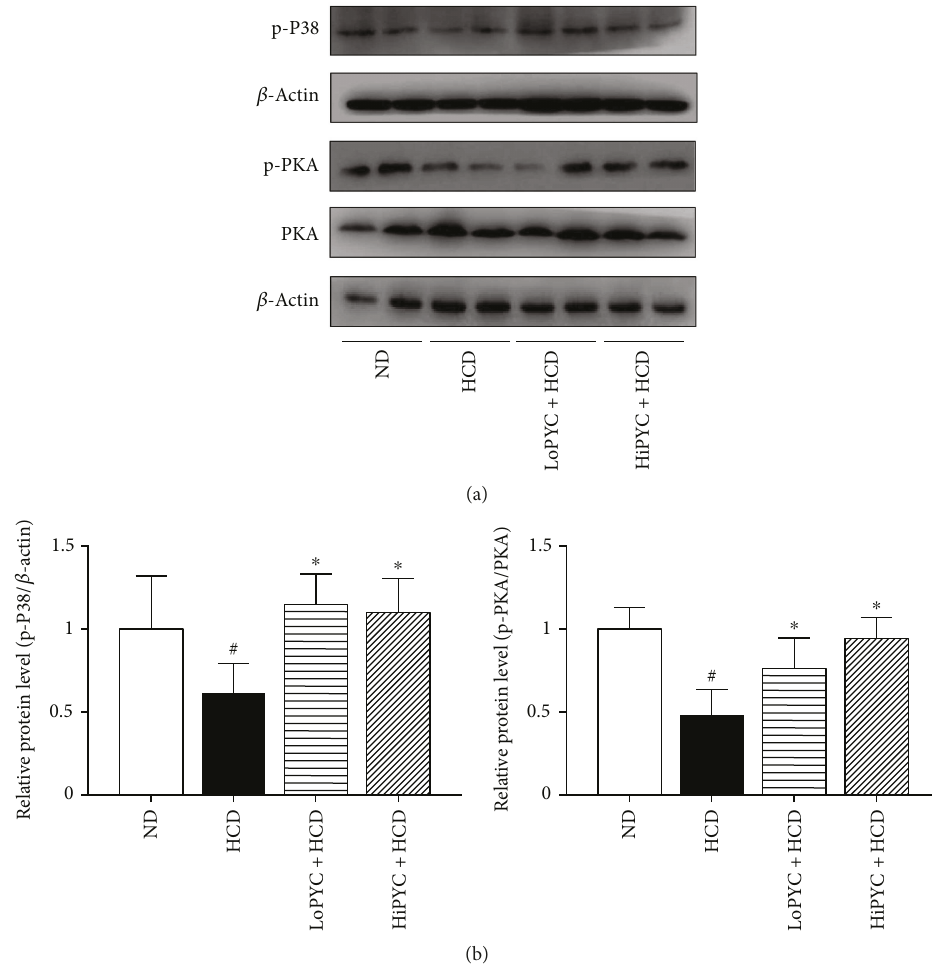
Figure 5: PYC increased the expression of proteins related to the PKA signaling pathway. (a) Results of the Western blot analysis of PKA signaling in eWAT, including p-p38 MAPK, p-PKA, and PKA, and (b) quanti fi cation of the bands. The data are expressed as the means ± SE for 3 mice per group. # p < 0 05 versus the ND group; ∗ p < 0 05 versus the HCD